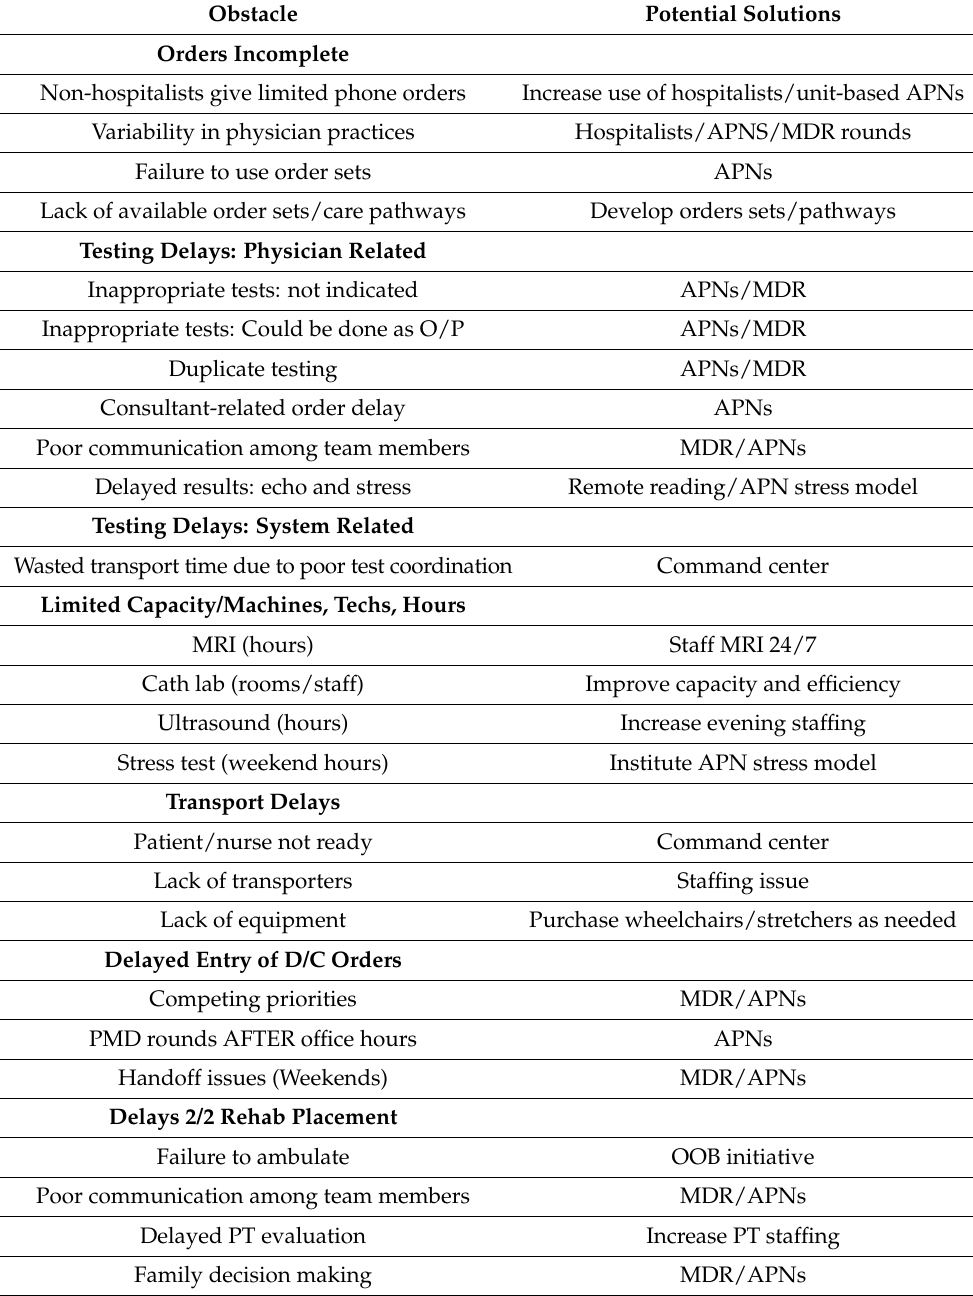
Table 1. Fishbone for in-hospital phase crosswalk. Abbreviations: advanced practice nurse (APN); multi-disciplinary rounds (MDR); discharge (D/C); physical therapy